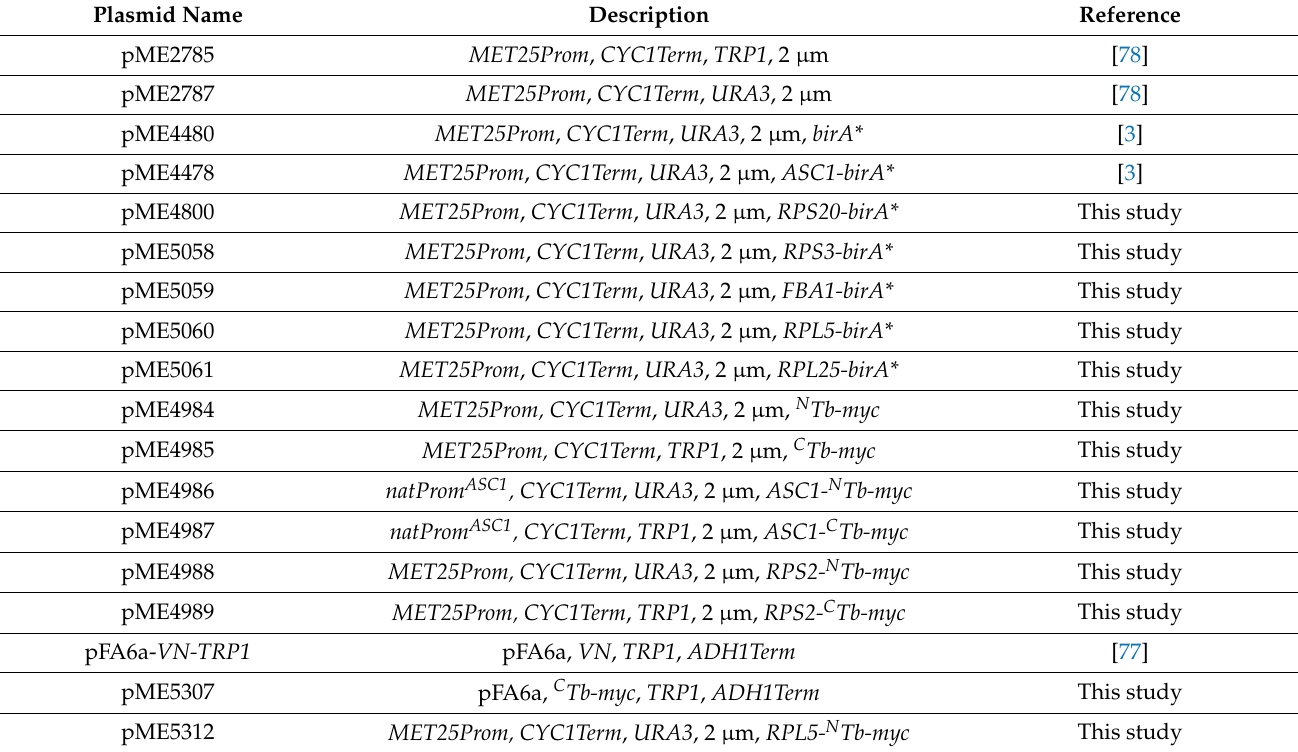
Table 1. Plasmids used in this